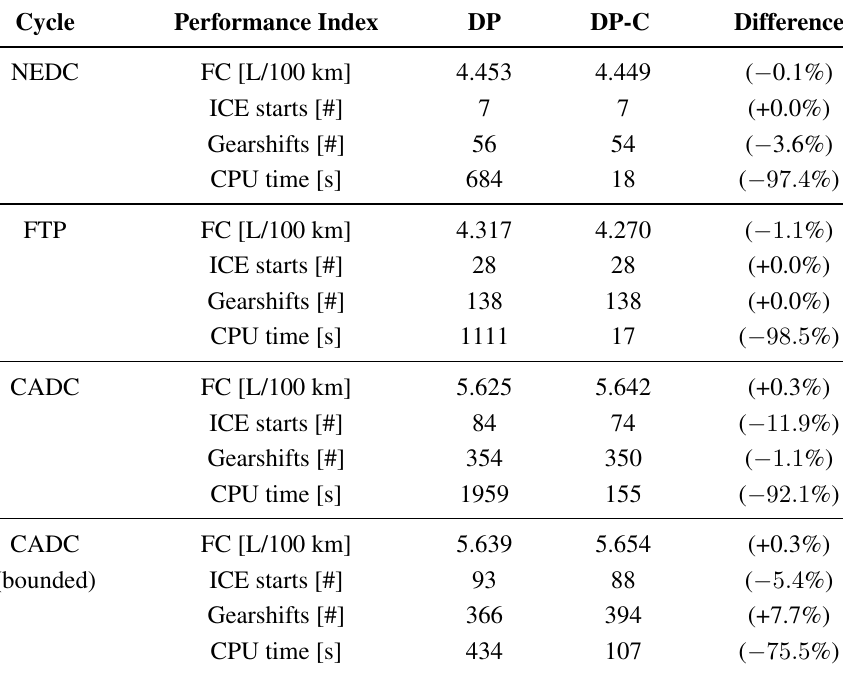
Table 3. Results with the nonlinear vehicle